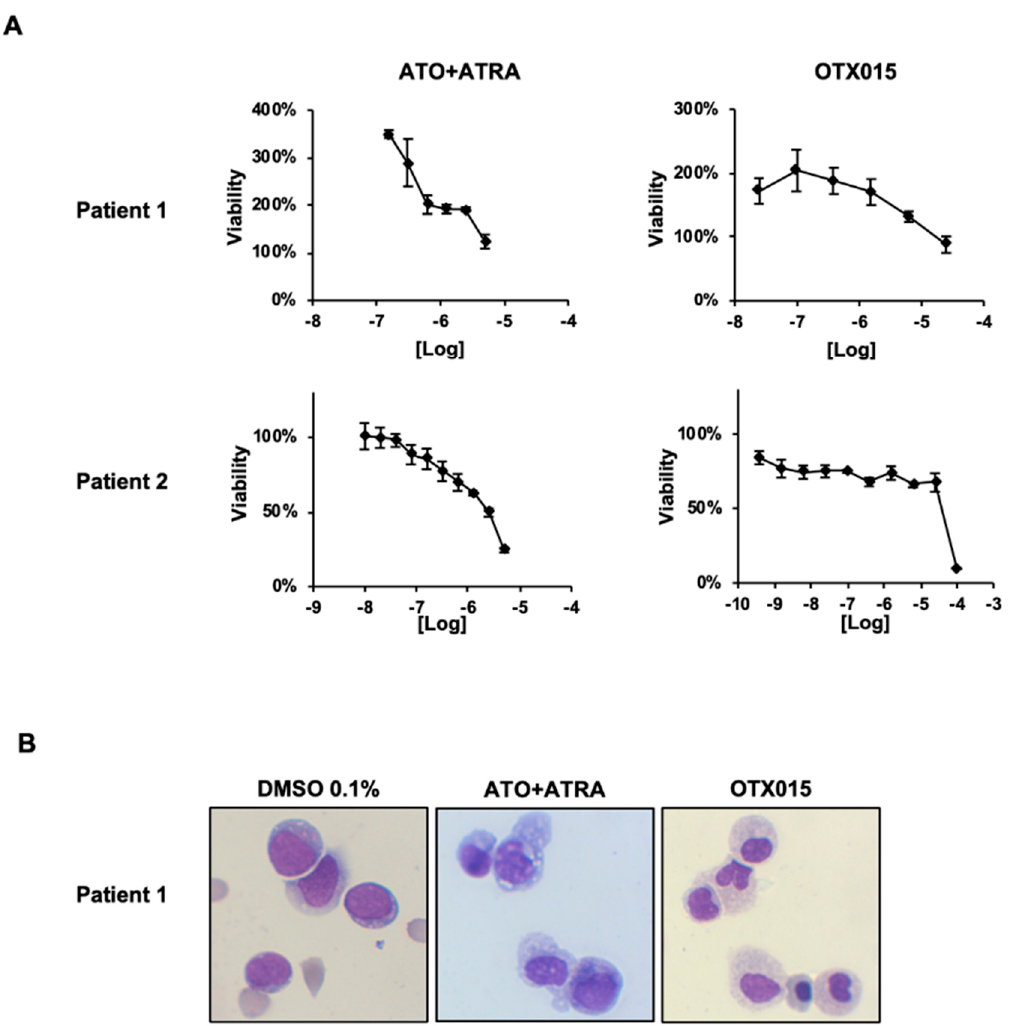
Figure 5. Effects of BETi in NPM1c patient-derived bone marrow blast cells. Primary leukemic bone marrow blast cells were obtained from two indicated NPM1c + AML patients. ( A ) For two patients, blast cells were exposed ex vivo for 72 h to increasing doses of indicated drugs and ApoTox-Glo TM assays were performed to determine viability of the patient cells. ( B ) Cell morphology of patient derived blast cells after treatment either with 0.1% DMSO, 1000 nM ATO + 1000 nM AT-RA, 500 nM or OTX015 (MK-8628) was studied at 48 h by May-Grünwald-Giemsa staining after cytospin.